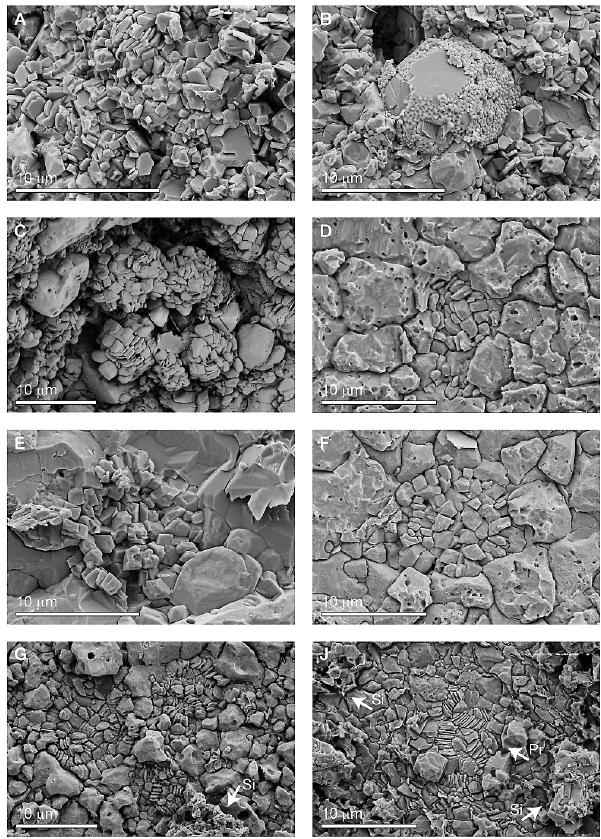
Fig. 6. Calcareous nannofossils from the late Norian and Rhaetian of the southern Apennines and Sicily. (A) Scales of Prinsiosphaera from the Misikella ultima conodont zone, Rhaetian of Pizzo Mon- dello, 54.5m in Fig. 2: fresh broken sample. In this example, Prin- siosphaera “calcispheres” cannot be discerned either because they were disarticulated, or because they have been compacted during burial. (B) Thoracosphaera geometrica from the Misikella ultima conodont zone, Rhaetian of Pizzo Mondello, 54.5m in Fig. 2: fresh broken sample. This and other nannofossils, different from Prin- siosphaera , are minor constituents of the carbonate sediment at Pizzo Mondello and were not recognized at Pignola-Abriola. (C) Prinsiosphaera from the Misikella posthernsteini conodont zone, Rhaetian of Pizzo Mondello, 40.25m in Fig. 2: surface of “cal- cispheres” within a primary cavity of the sediment. (D) Prin- siosphaera from the Parvigondolella andrusovi–Misikella hern- steini conodont zone, late Norian of Pizzo Mondello, 19.95m in Fig. 2: polished and etched sample. (E, F) Prinsiosphaera from the Mockina bidentata conodont zone, late Norian of Pizzo Mon- dello, 13.1m in Fig. 2: comparison of the freshly broken sample (E) and polished and etched sample (F) . (G) Three specimens of Prinsiosphaera with different diameters from the Mockina biden- tata conodont zone, late Norian of Pignola-Abriola, 23.7m in Fig. 3. This sample was polished and etched. Silicification (Si) is visible. (J) Prinsiosphaera (Pr) and silicified patches (Si) from the Misikella posthernsteini conodont zone, Rhaetian of Pignola-Abriola, 52.1m in Fig. 3. Polished and etched